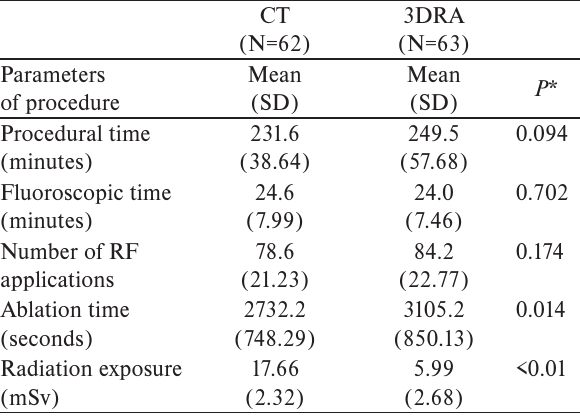
Table 2. Procedure results.